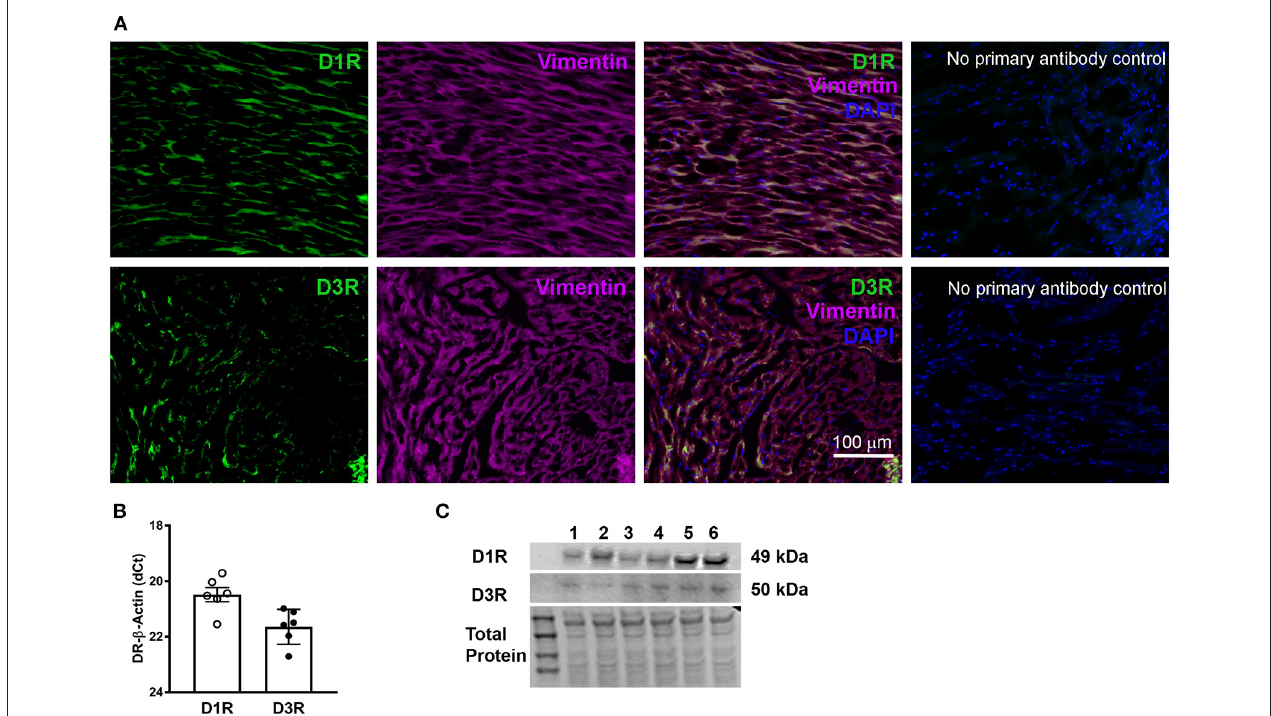
FIGURE 1 | The expression and distribution of dopamine receptors, D1R and D3R in mouse hearts: (A) Representative photomicrographs showing immunofluorescence staining of D1R and D3R which co-localized with vimentin, a cardiac fibroblast-specific marker, in the heart tissue sections. No primary antibody control sections were incubated with the antibody diluent alone and no primary antibody, followed by incubation with secondary antibodies and DAPI (the nuclear stain), which confirms the antibody specificity of D1R and D3R. (B) Gene expression was determined using TaqMan primers by real-time qPCR. The normalized -dCT values indicate that there is relatively higher expression of D1R compared to D3R in cardiac tissue. (C) Receptor protein expression determined by western blot using receptor specific antibodies as described in methods